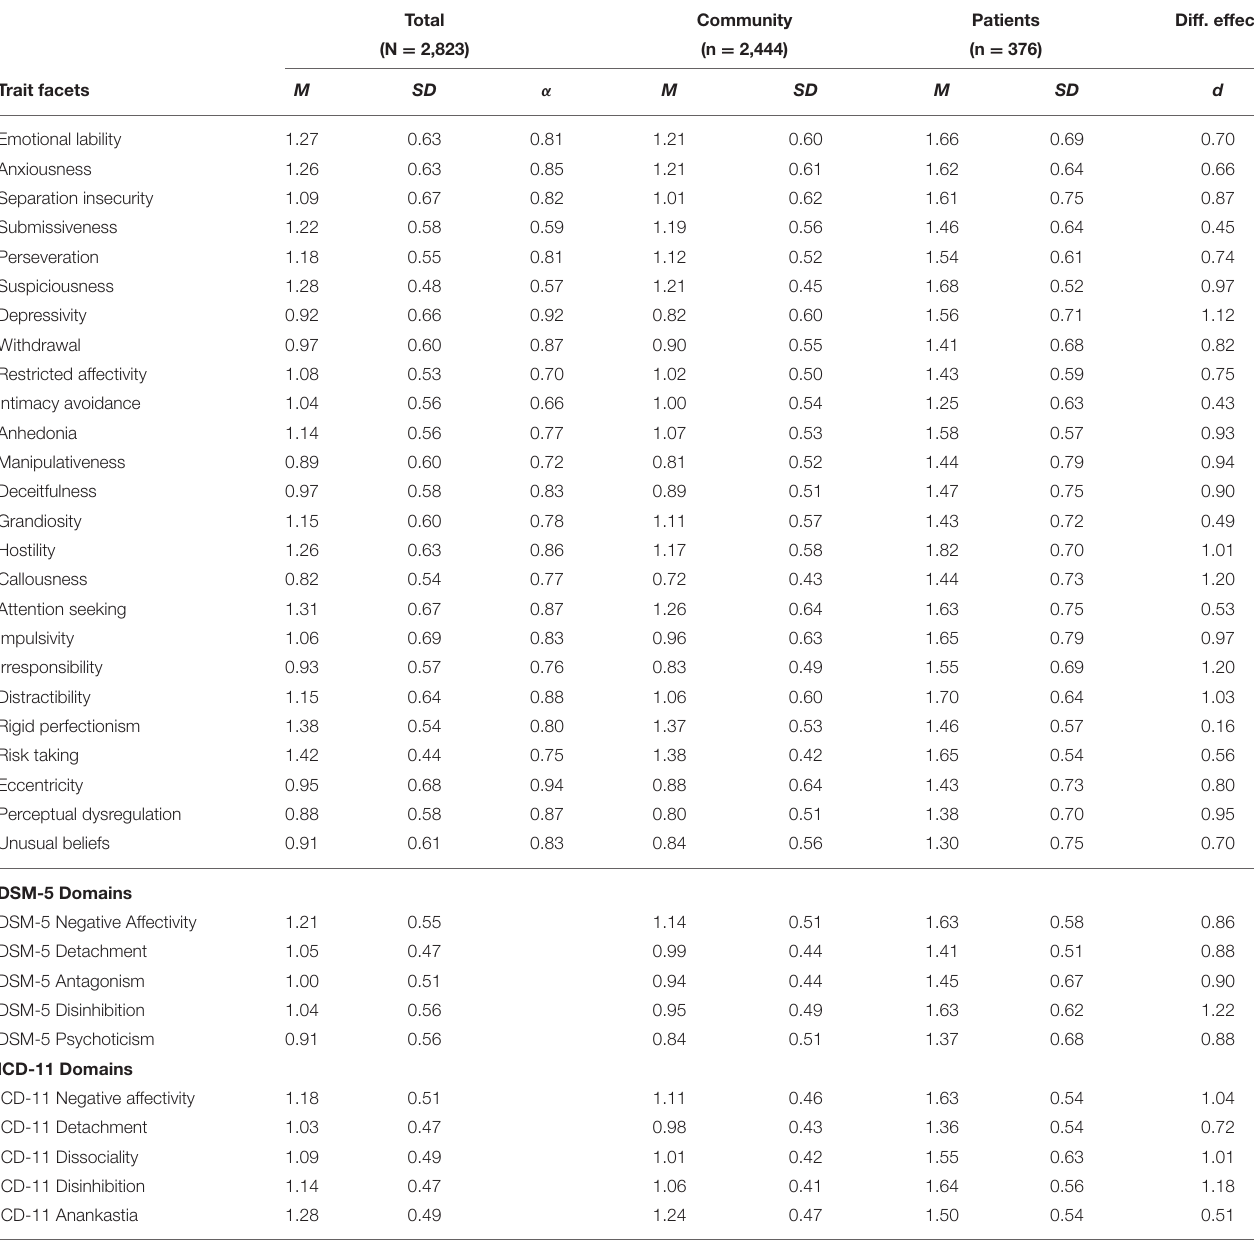
TABLE 2 | Scale statistics and group differences for PID-5 facets and DSM-5 and ICD-11 domain scores. Total Community Patients Diff.